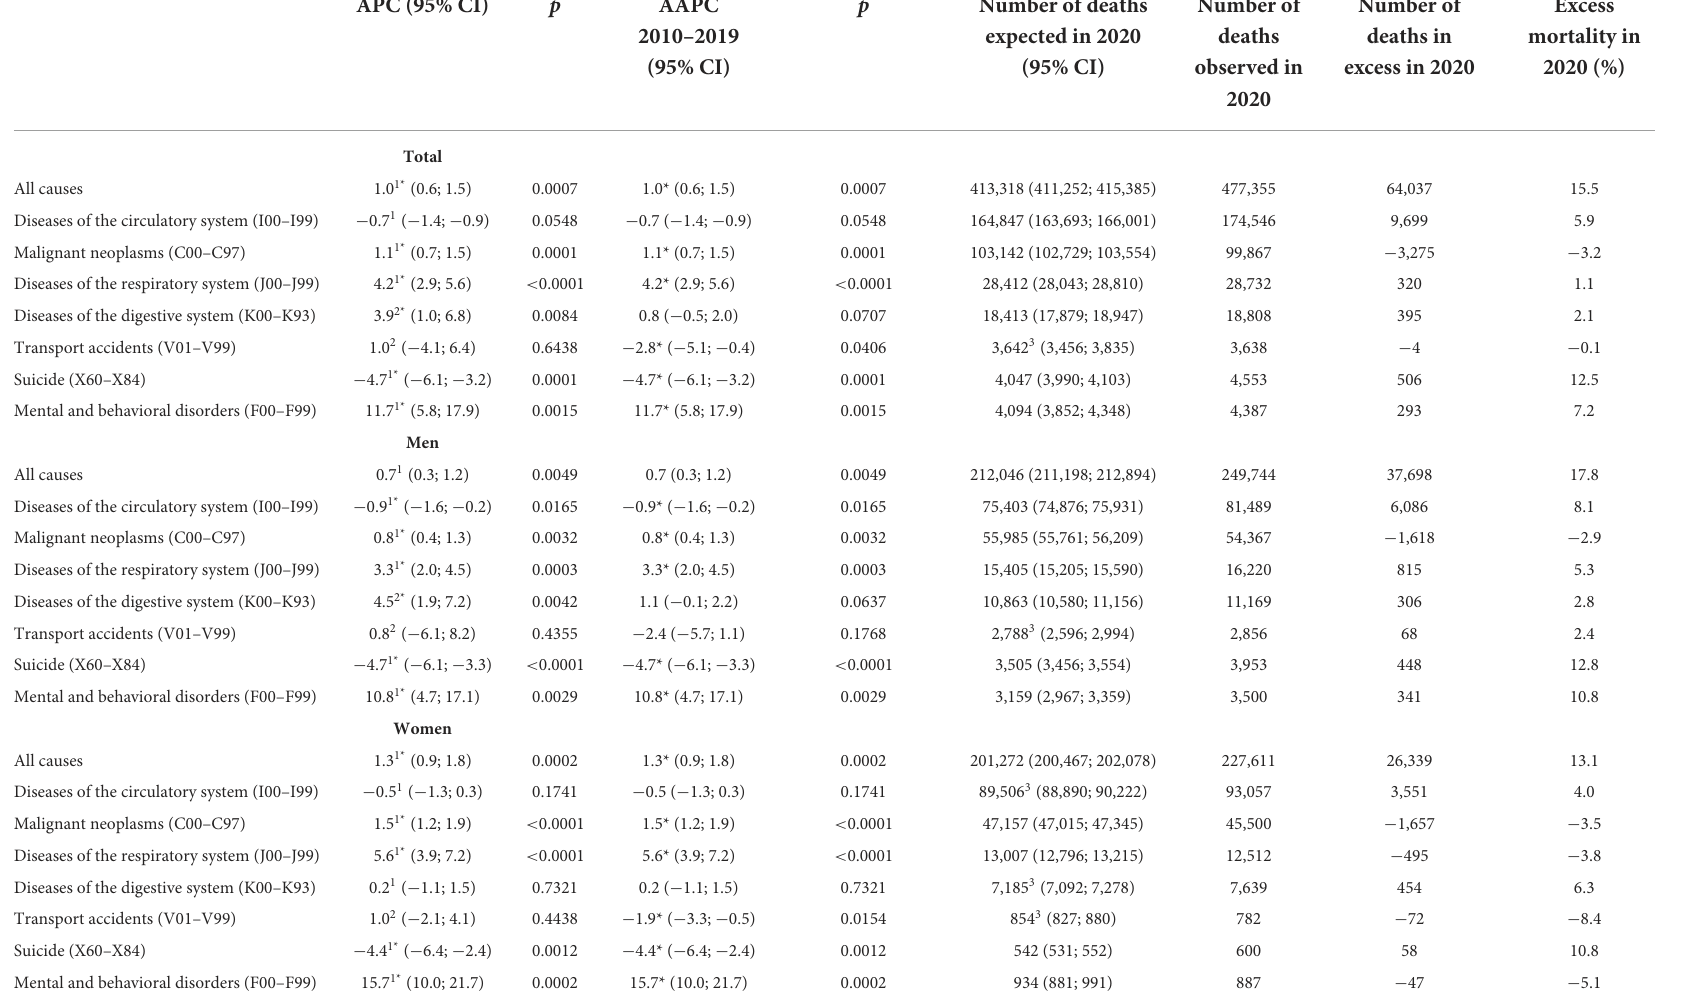
TABLE 2 Excess deaths in 2020 in total and due to selected causes in